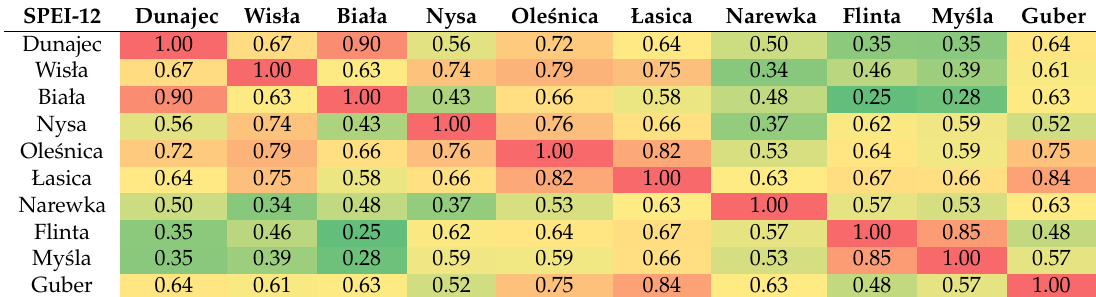
Table 5. Pearson correlation coefficient between SPEI-12 in 1971-2000 estimated for ten studied catchments.